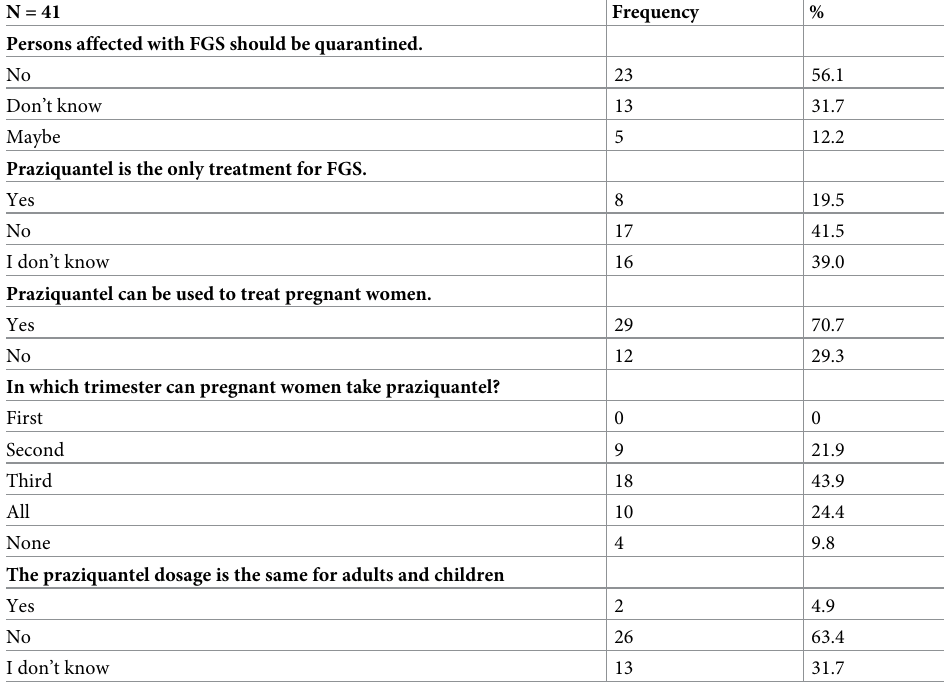
Table 4. Knowledge about the management of FGS patients during routine healthcare service. N =